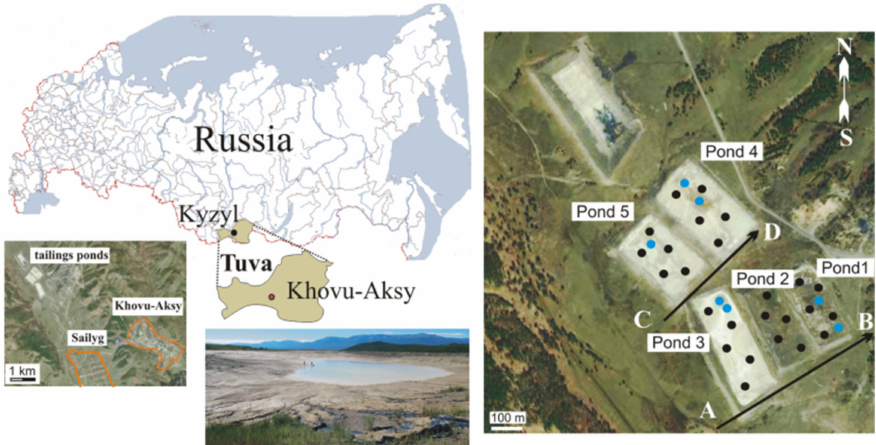
Figure 1. Geographical position, sampling scheme, and location of geophysical study and photograph of the pond 5 with surface reservoir at the territory of the tailings ponds. Black circles are sample points, blue circles are points of water samples, and black arrows represent the profiles of the electrical resistivity